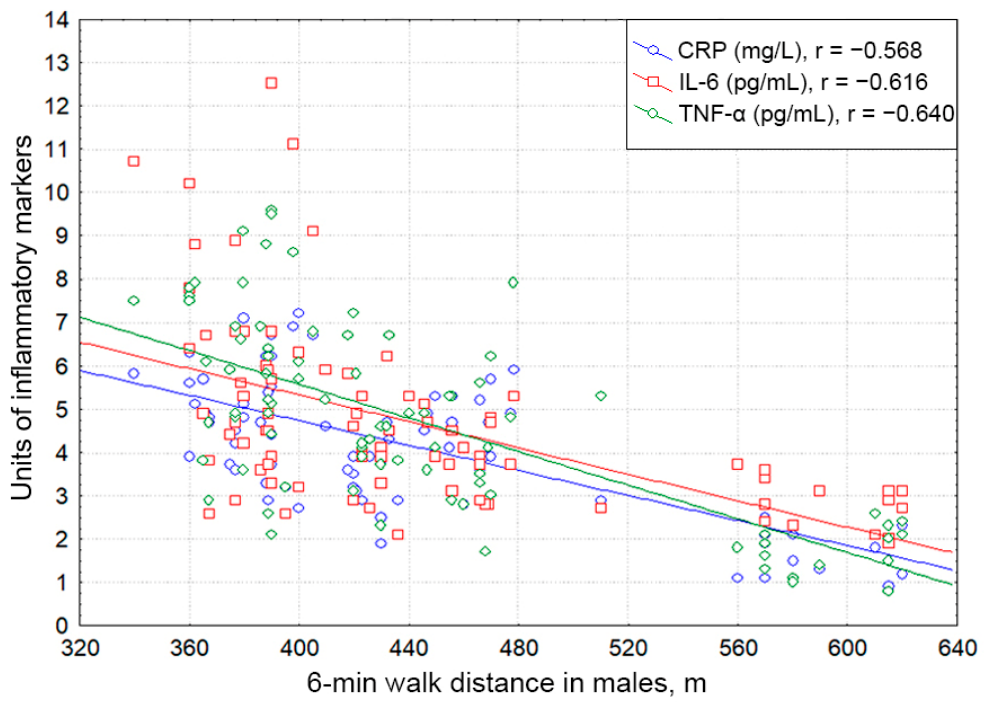
Figure 6. Correlative associations between C-reactive protein, interleukin-6, and tumor necrosis factor alpha serum levels and 6 min walk test results in males with hypertension complicated by CHF with preserved ejection fraction. Each dot represents a participant. Abbreviations: CRP: C-reactive protein, TNF- α : tumor necrosis factor alpha, IL-6: interleukin-6.